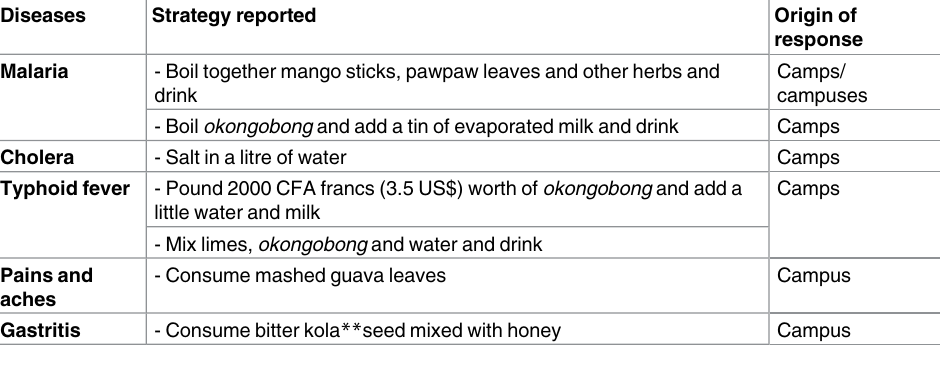
Table 1. Reported remediesfor treating